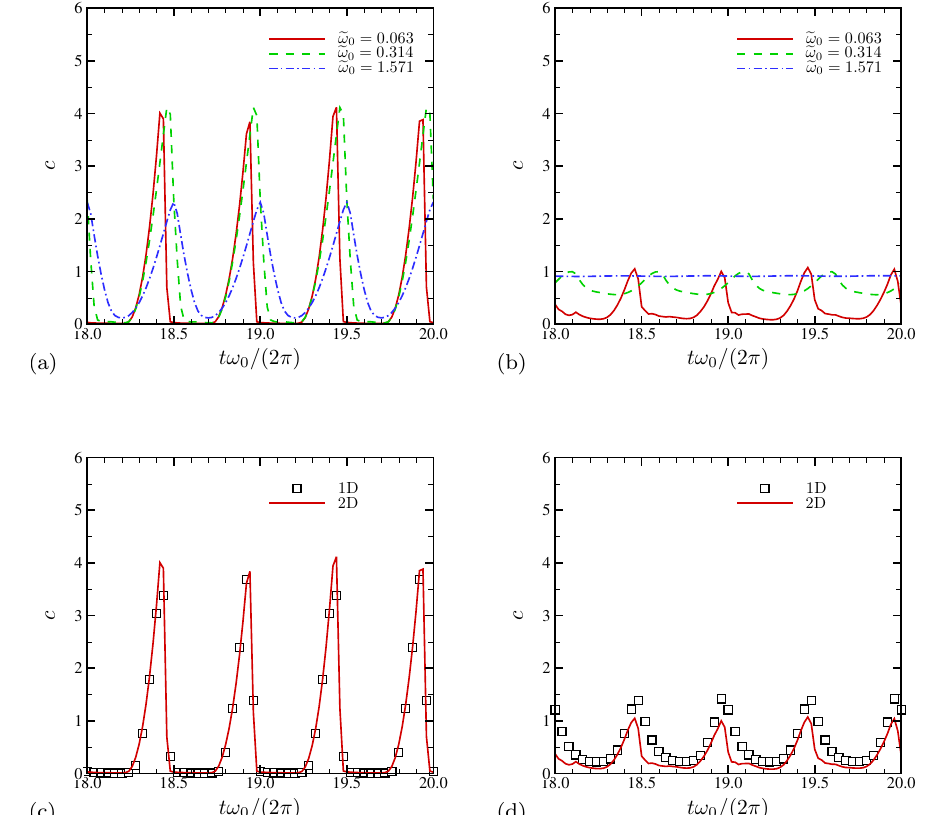
Figure 9. Time history of instantaneous salt concentration averaged in the horizontal direction at ( a ) x 2 / L = 0.01 and ( b ) x 2 / L = 0.1. In ( c , d ), only the results for with the corresponding 1D simulation. Two oscillations periods are